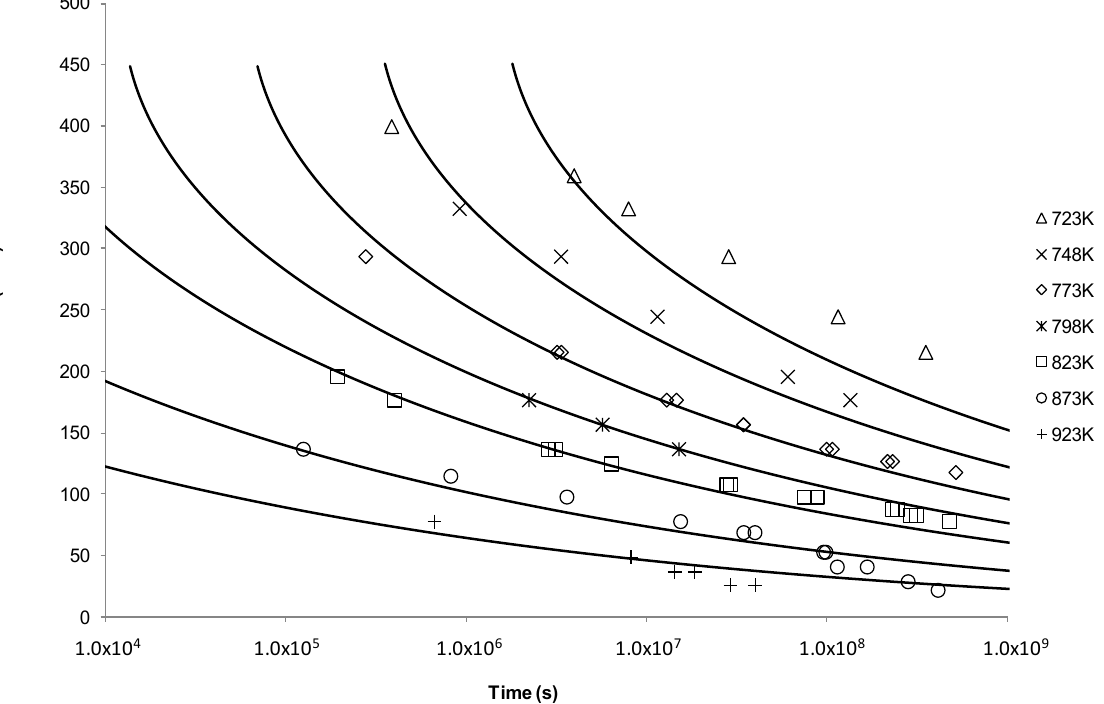
Figure 9. The stress vs . time to fracture curves of the Minimum Commitment method using Grade 22 Steel creep data.